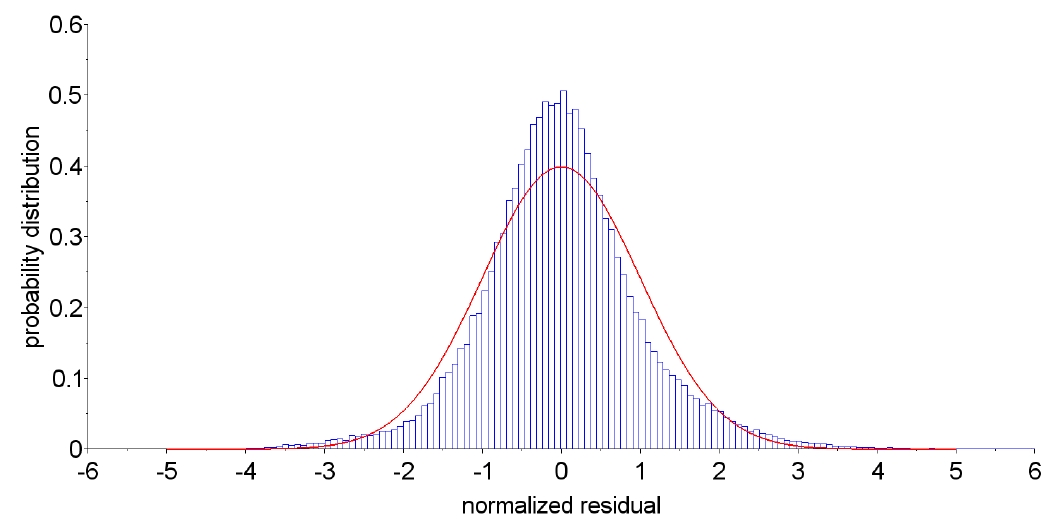
Figure 16. Histogram of normalized residual. The x -axis unit dimension less. The red line is a standard normal distribution at